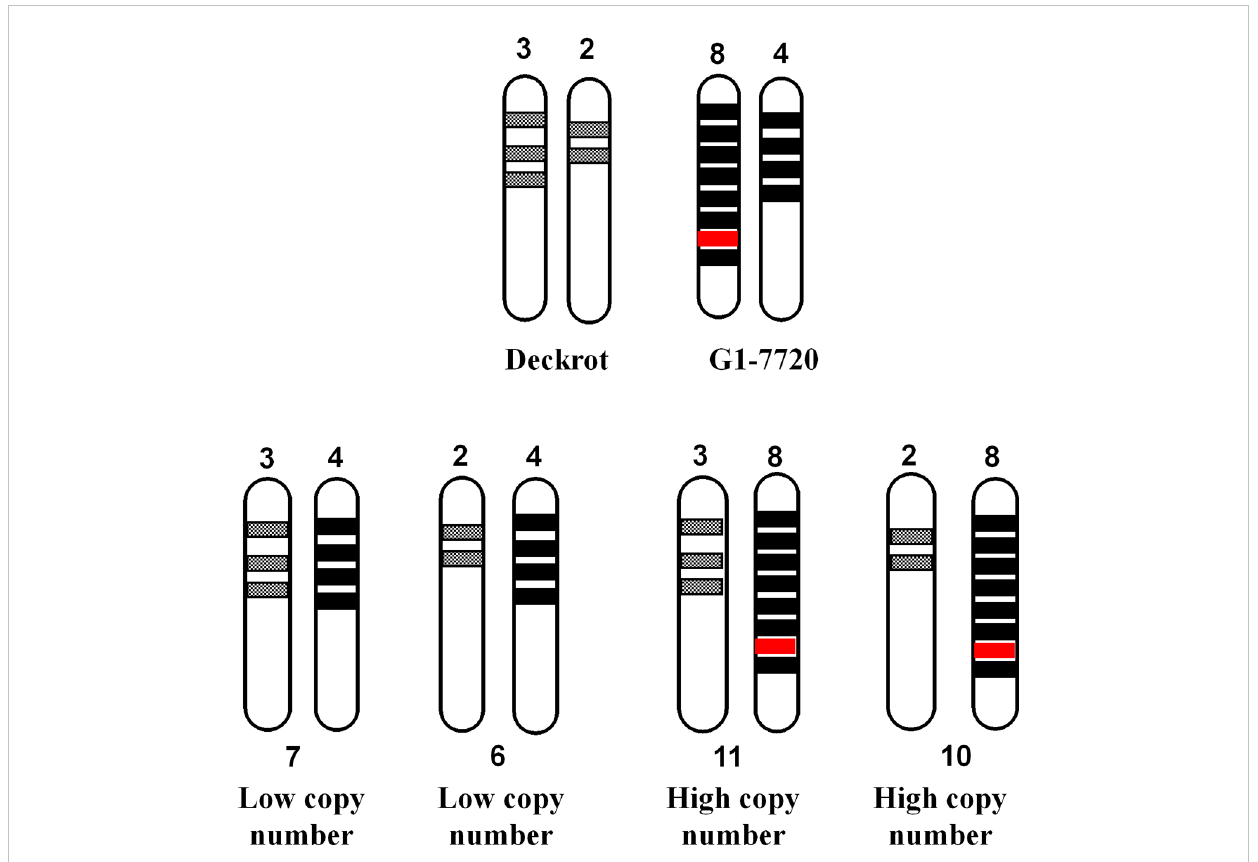
FIGURE 10 A diagram to explain the correlation between VvTer copy number and cyclic monoterpene accumulation. VvTer genes are represented by shaded blocks and the “ hyper-functional ” gene is shown in red. The “ hyper-functional ” gene falls on the parent allele with the highest copy number and is the causal factor for higher cyclic monoterpene content in this parent. The progeny from ‘ Deckrot ’ x G1-7720 have an equal chance having one of four possible VvTer copies: 6, 7, 10 or 11. Progenies with 6 or 7 copies would be considered “ low copy number ” individuals and would not inherit the “ hyper-functional ” gene resulting in lower/normal accumulation of cyclic monoterpenes. Progenies with 10 or 11 copies would be considered “ high copy number individuals ” and will inherit the “ hyper-functional ” gene resulting in higher cyclic monoterpene